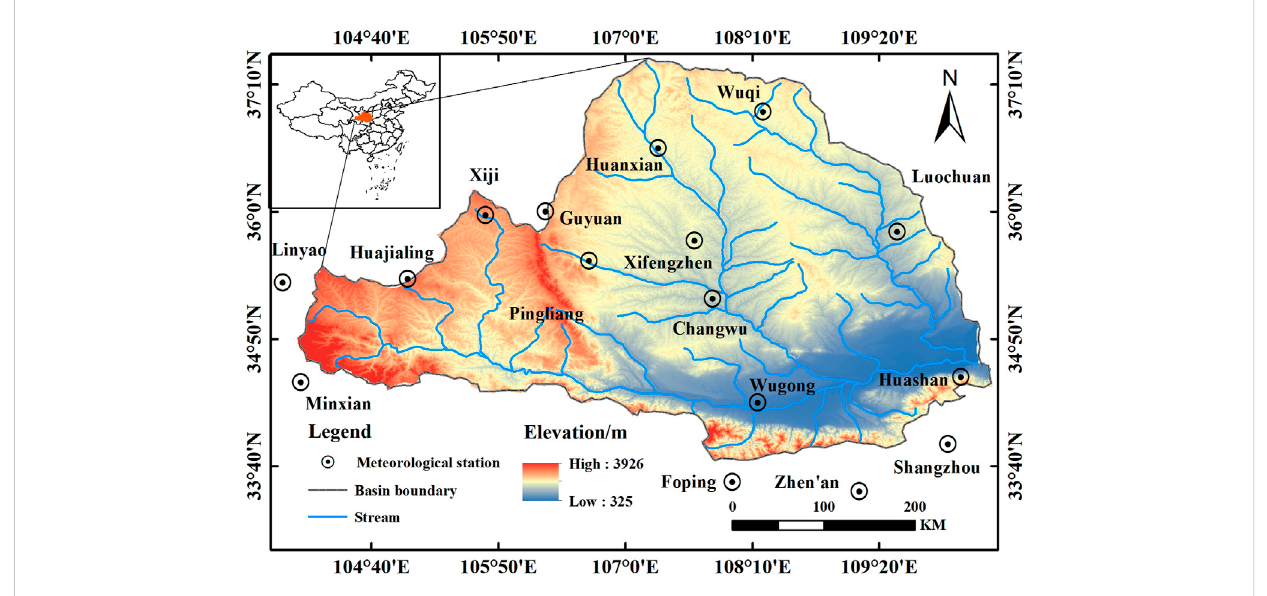
FIGURE 1 Geographical location of the Weihe River basin and distribution of each meteorological